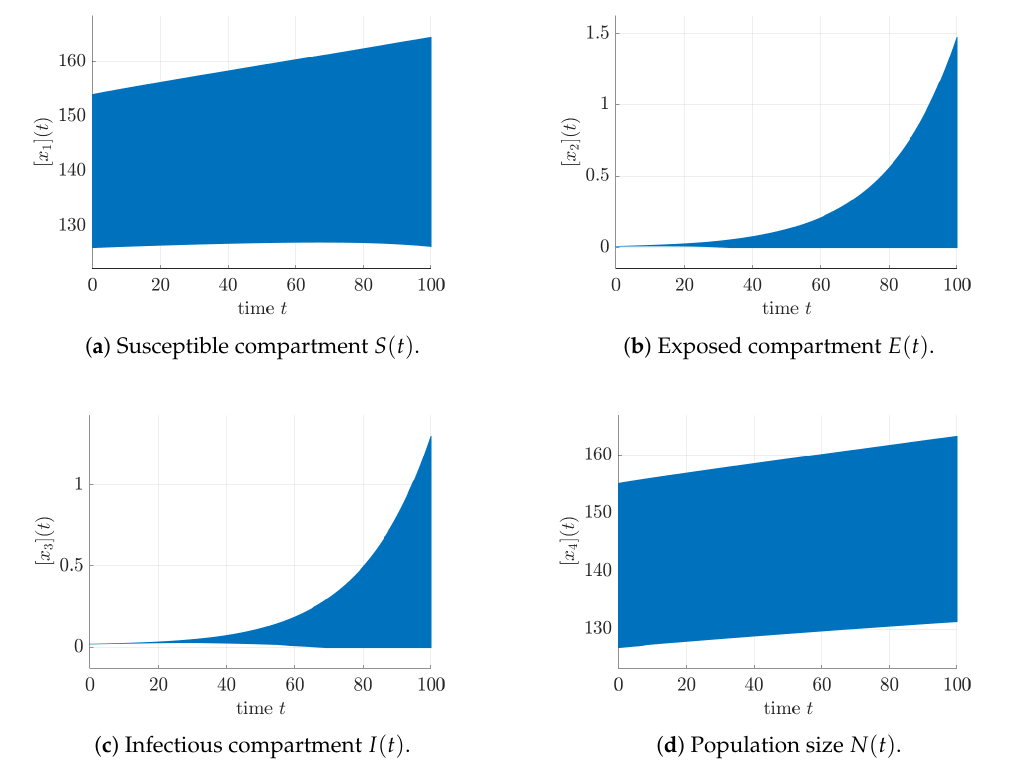
Figure 9. State enclosures for the SEIR model in Scenario 3 with the initial conditions